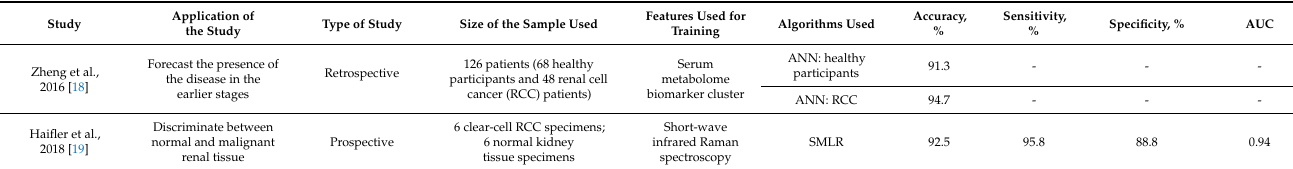
Table 3. Studies using AI to diagnose renal